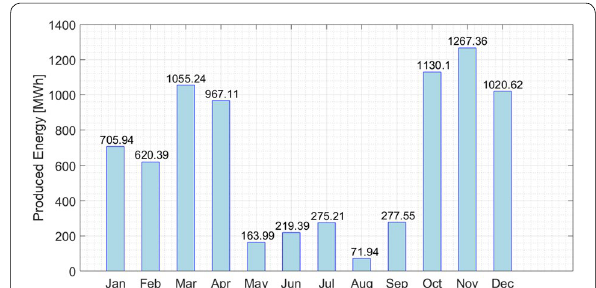
Fig. 5 Annual wind energy production on Santa Maria island